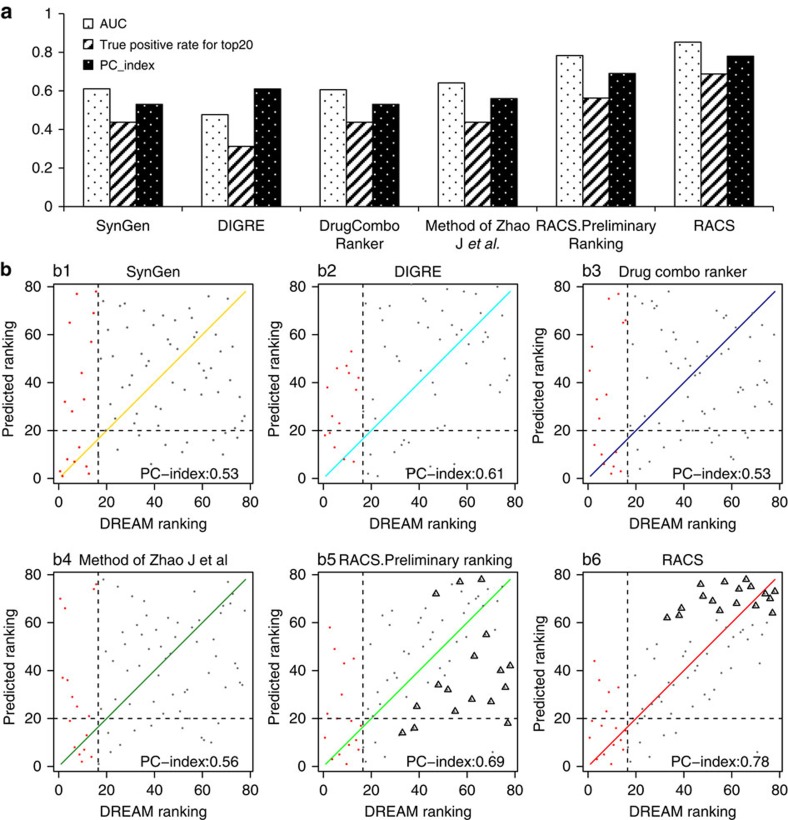
Performance of RACS on human β-cell lymphoma cell line OCI-LY3 data.(a) Performance comparison of different ranking methods. White bar with black points: barplot for AUC metric. White bar with black slashes: barplot for true positive rate for the top 20 predicted pairs. Black bar with white points: barplot for PC-index. (b) Detailed ranking agreement between DREAM and computational models. The red dots are true synergistic drug combinations, while the grey dots are the non-synergistic ones confirmed from DREAM experiments. The desired models would be able to map dots into the diagonal line as much as possible. The vertical black dashed lines indicate the boundary between the top 16 synergistic pairs and non-synergistic ones, while the horizontal black dashed line illustrates boundary between the top 20 predicted ranking and the rest 58 ones. b5-b6: The dots with triangle are those pairs being filtered out to down-list from the preliminary ranking in RACS.